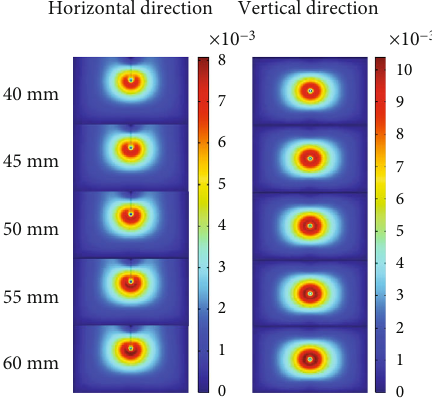
Figure 9: Displacement cloud of coal body with di ff erent vent